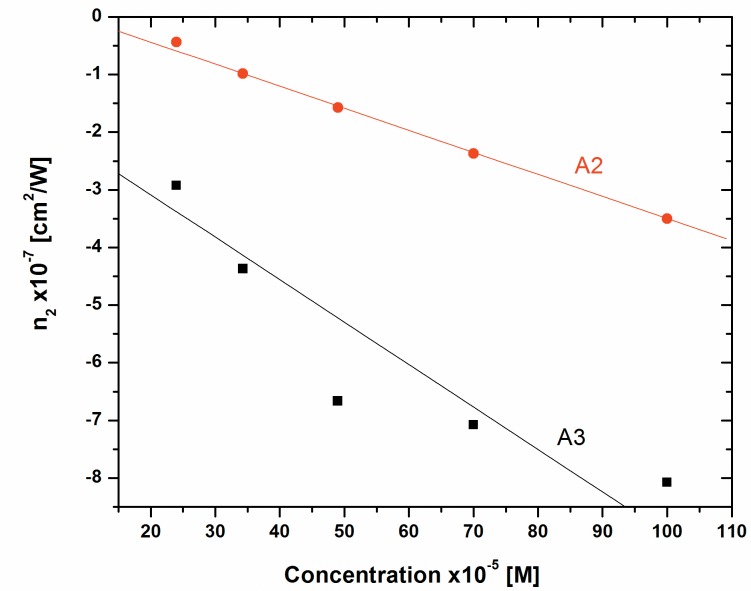
Variation of nonlinear refraction of Dyes A2 and A3 as a function of concentration.